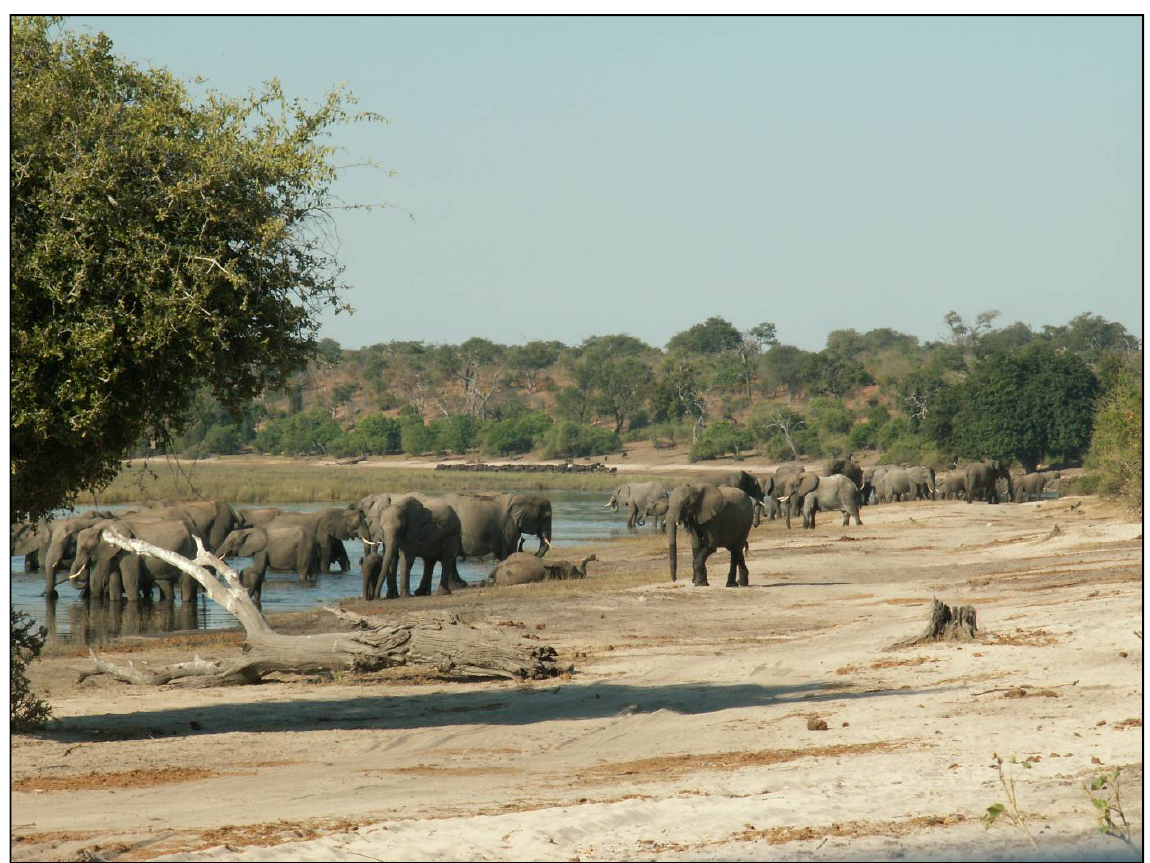
Figure 7. The river’s edge in Chobe National Park, Botswana, is highly utilized by elephants and other species in the dry season. Extensive trampling results in scare vegetation and large amounts of bare soil, influencing Moving Standard Deviation Index (MSDI) values for this area. Photo credit: T.